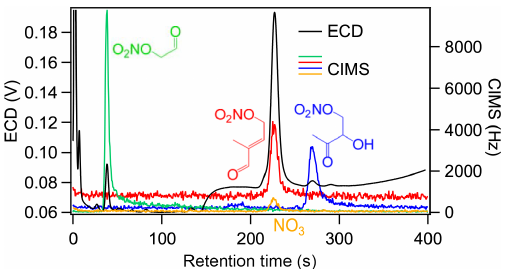
Figure 14. The formation of ethanal nitrate (a) and MVK ni- trate (b) relative to the loss of the isoprene nitrooxy enal for the Figure 13. The GC-ECD/CIMS spectra for the nitrooxy enal (red), OH + nitrooxy enal oxidation MVK nitrate (blue), and ethanal nitrate (green). The reaction of io- dide with the nitrooxy enal generated NO − ion (orange). The ECD 3 chromatogram is shown in black.